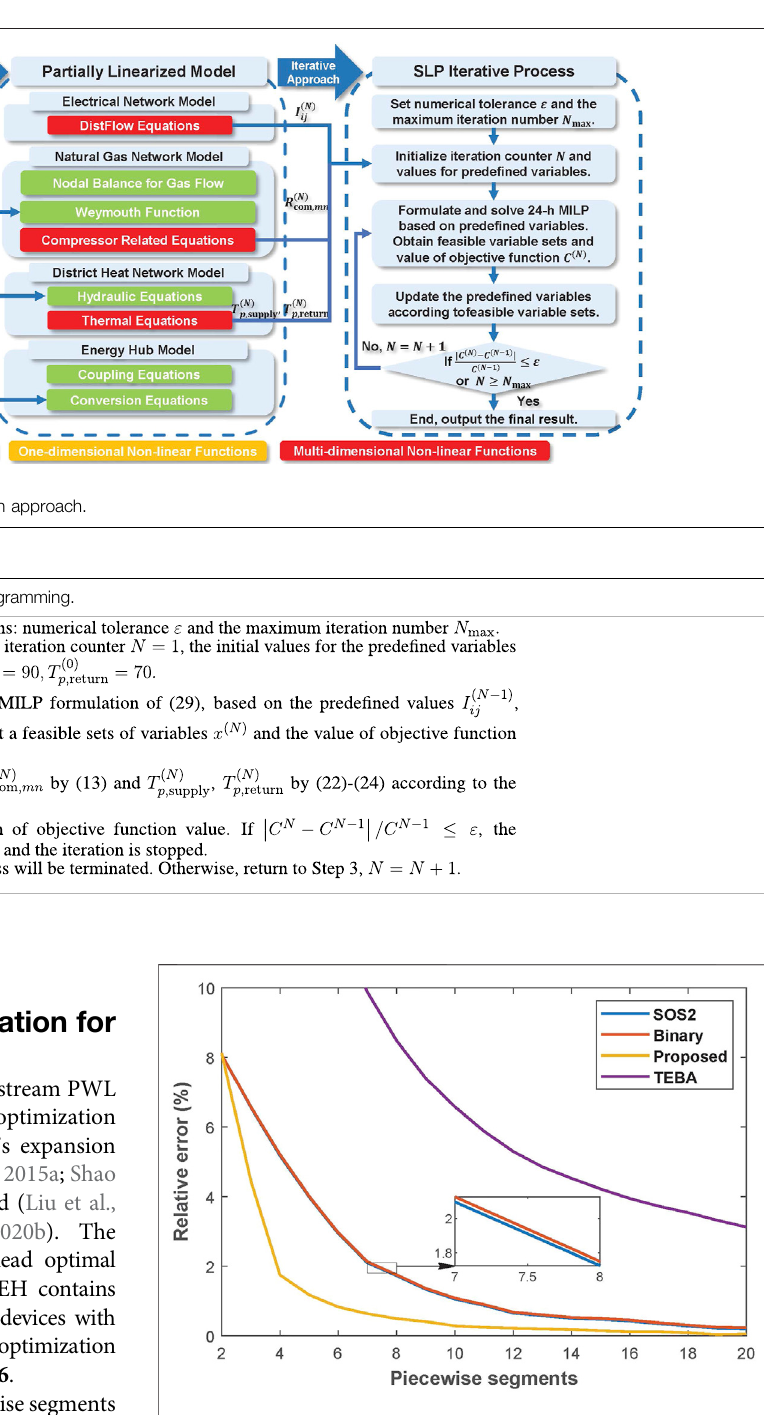
FIGURE 5 | Relative errors of four PWL approaches with increasing